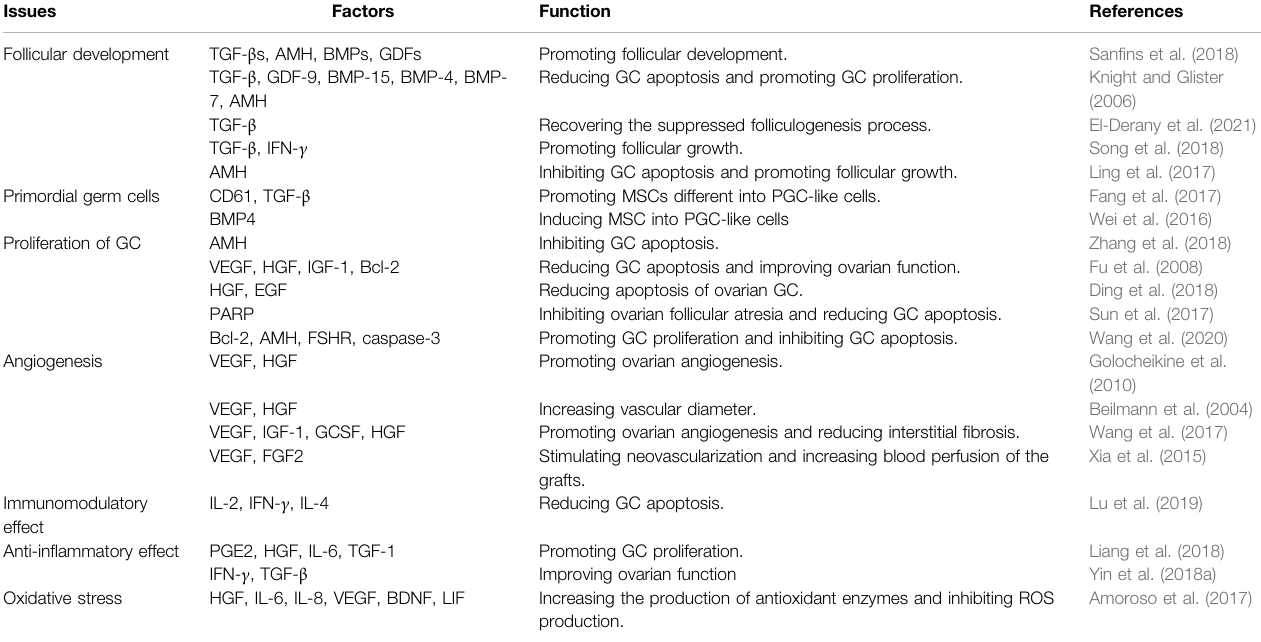
TABLE 3 | Factors involved in the process of MSC treatment of